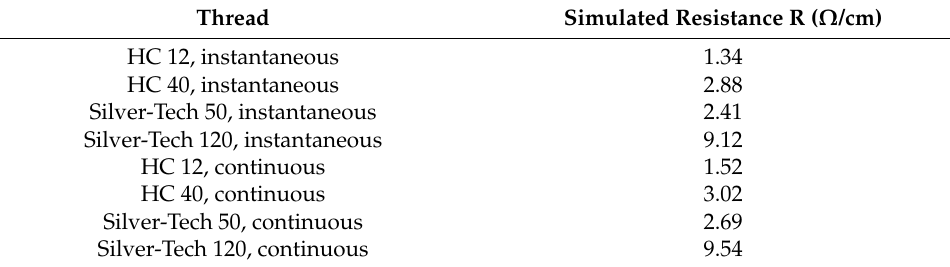
Table 2. Simulated Resistance Values of the Supplied Thread